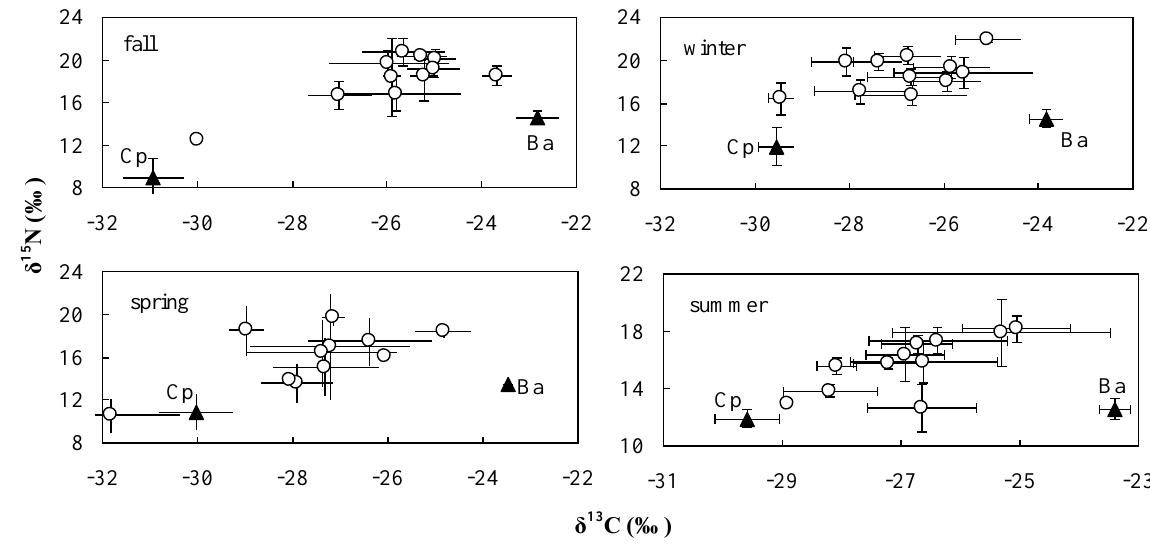
FIGURE 2. The δ 15 N plotted against δ 13 C of 11 consumer species (open circles) and two baseline indicators (solid triangles) in different seasons (fall, winter, spring, and summer). The δ 13 C and δ 15 N values were expressed by mean ± 1SD. Ba: snail Bellamya aeruginosa ; Cp: mussel Cristaria plicata